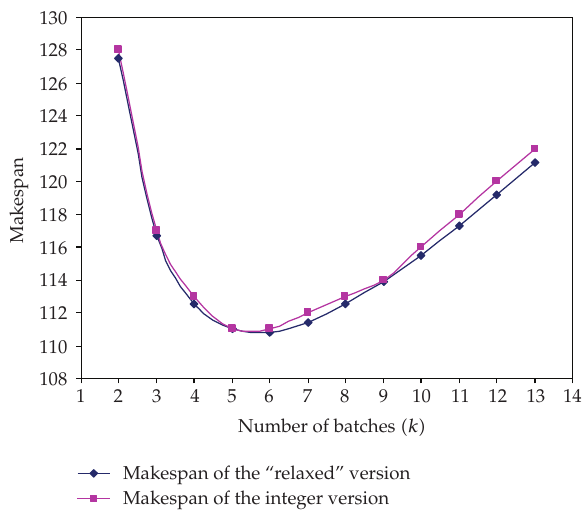
Figure 2: Makespan as a function of the number of batches for the relaxed and the integer versions (cid:8) 2 ,s (cid:8) 3 (cid:6) . (cid:5) Example 3.2: n (cid:8) 80 ,s 1 < s 2 ,s 1 2 we obtain n 1 (cid:8) n/k − (cid:5)(cid:5) k − 1 (cid:6) / 2 (cid:6)(cid:5) s 2 − s 1 (cid:6) ≥ 0. Consequently, 1 / 2 −